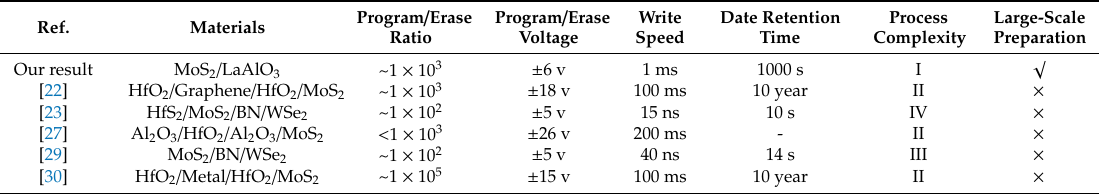
Figure 4. Device-to-device repeatability test from six different regions. ( a ) Sweeping in ± 6 v. ( b ) Figure4. Device-to-devicerepeatabilitytestfromsixdifferentregions. ( a )Sweepingin ± 6v. ( b )Sweeping Sweeping in ± 4 v. ( c ) Sweeping in ± 6 v. in ± 4 v. ( c ) Sweeping in ± 6 v. Table 1. Comparison of the performance of memory with other